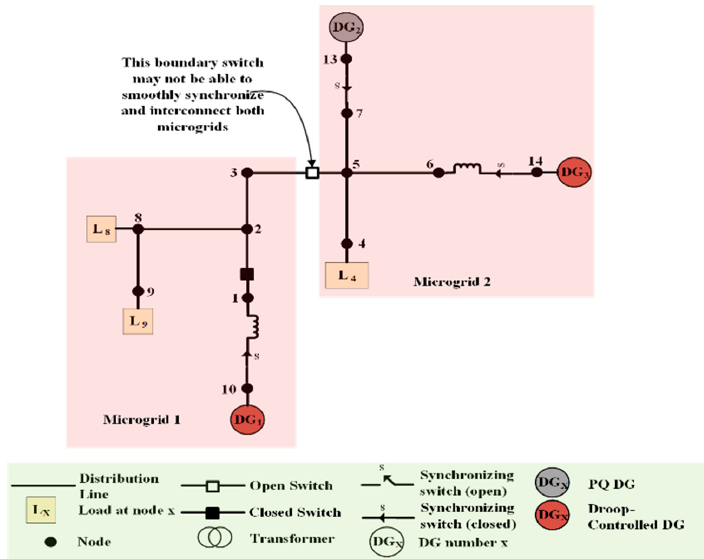
Figure 6. Parallel restoration with master DG and problem with synchronization and interconnecting the restored microgrids.